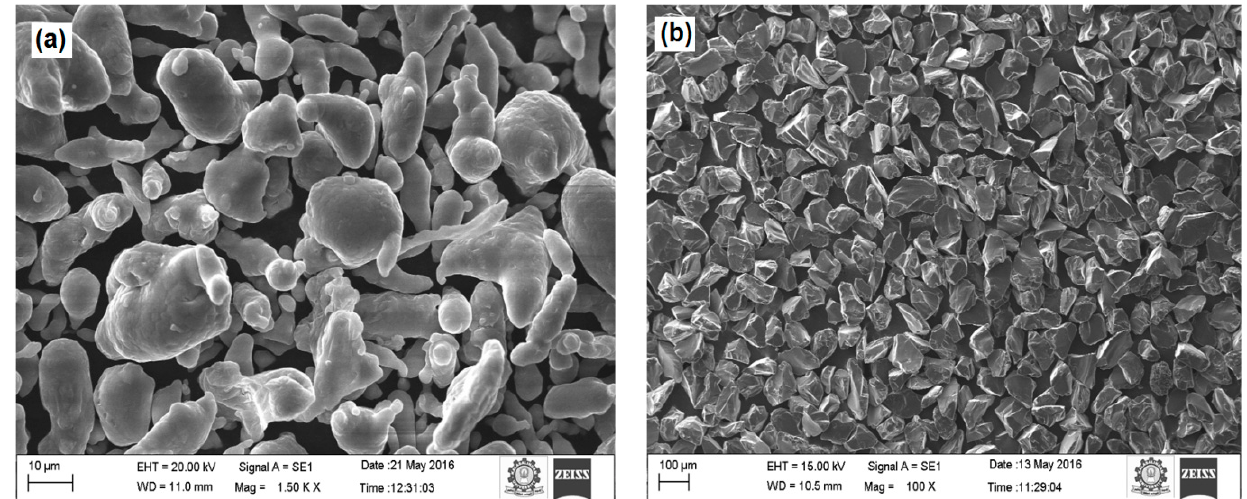
Figure 1. SEM images of the as-received ( a ) Al and ( b ) B 4 C. The composite powders were synthesized using high energy ball mill for 10 h (VBCRC Planetary ball mill). The drum speed was 100 rpm. A steel ball with 10 mm diameter was used. The ball to powder ratio was 5:1. To avoid the temperature rising, a cooling process was carried out every 10 min as per [27]. The green compacts were made into billets of dimensions 24 mm diameter and 12 mm height using a computer servo-controlled ball screw driven UTM (Model: M Series). To avoid the friction between the punch and die, zinc stearate was used as lubricant. Figure 2 shows the details of powders and ball milling setup.